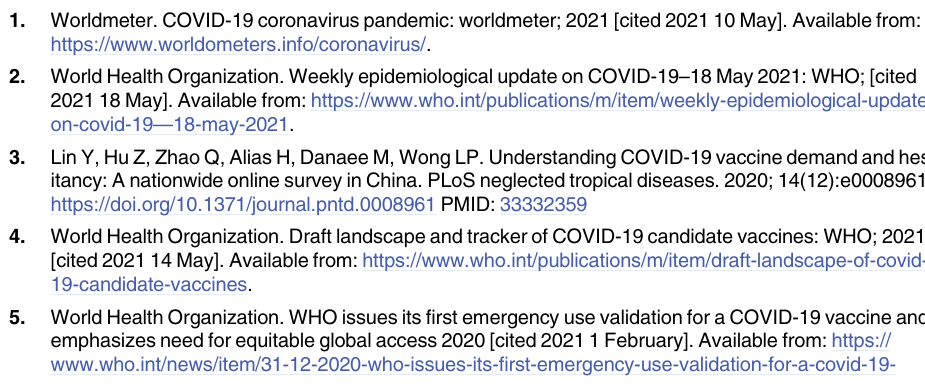
S1 Table. The English version of the 5C questionnaire. S2 Table. The Arabic validated 5C questionnaire. S3 Table. Inter-item correlations of the Arabic version of the 5C scale.